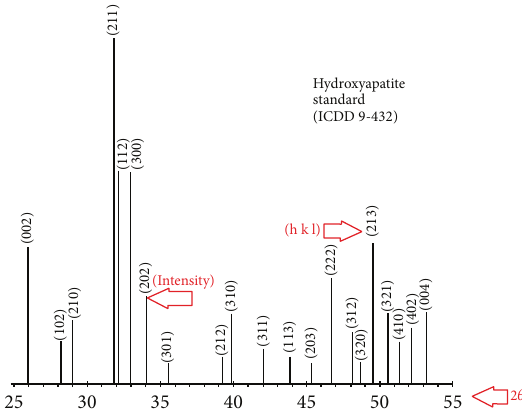
Figure 1: The standard XRD peaks of hydroxyapatite (based on ICDD 9–432).